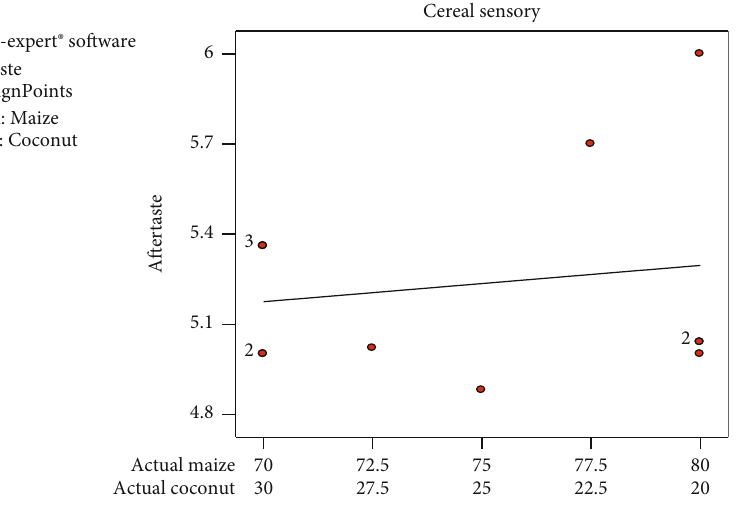
Figure 6: Mean graph for aftertaste sensory responses on the samples.